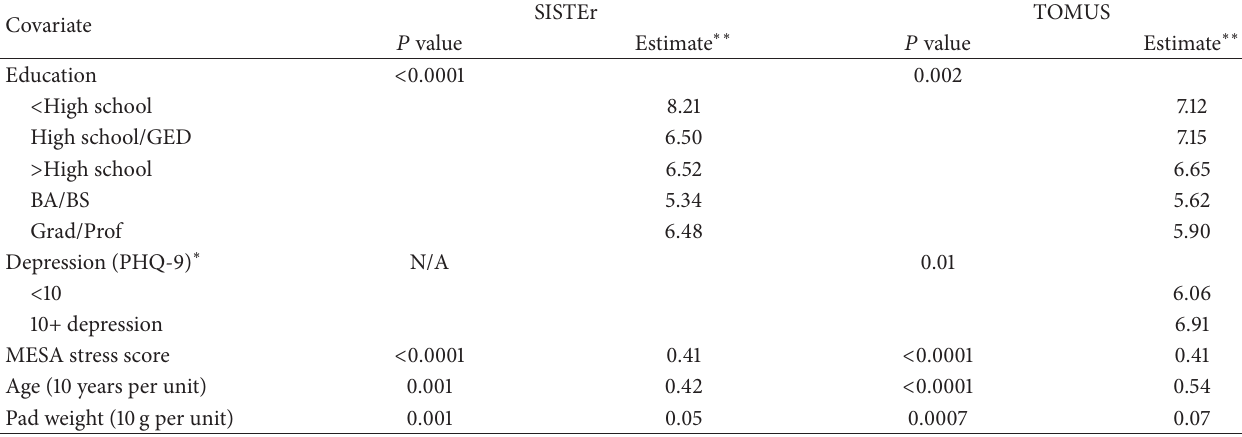
Table 3: Final multivariable linear regression models for the SISTEr and TOMUS trials with outcome urge symptoms from the MESA scale.